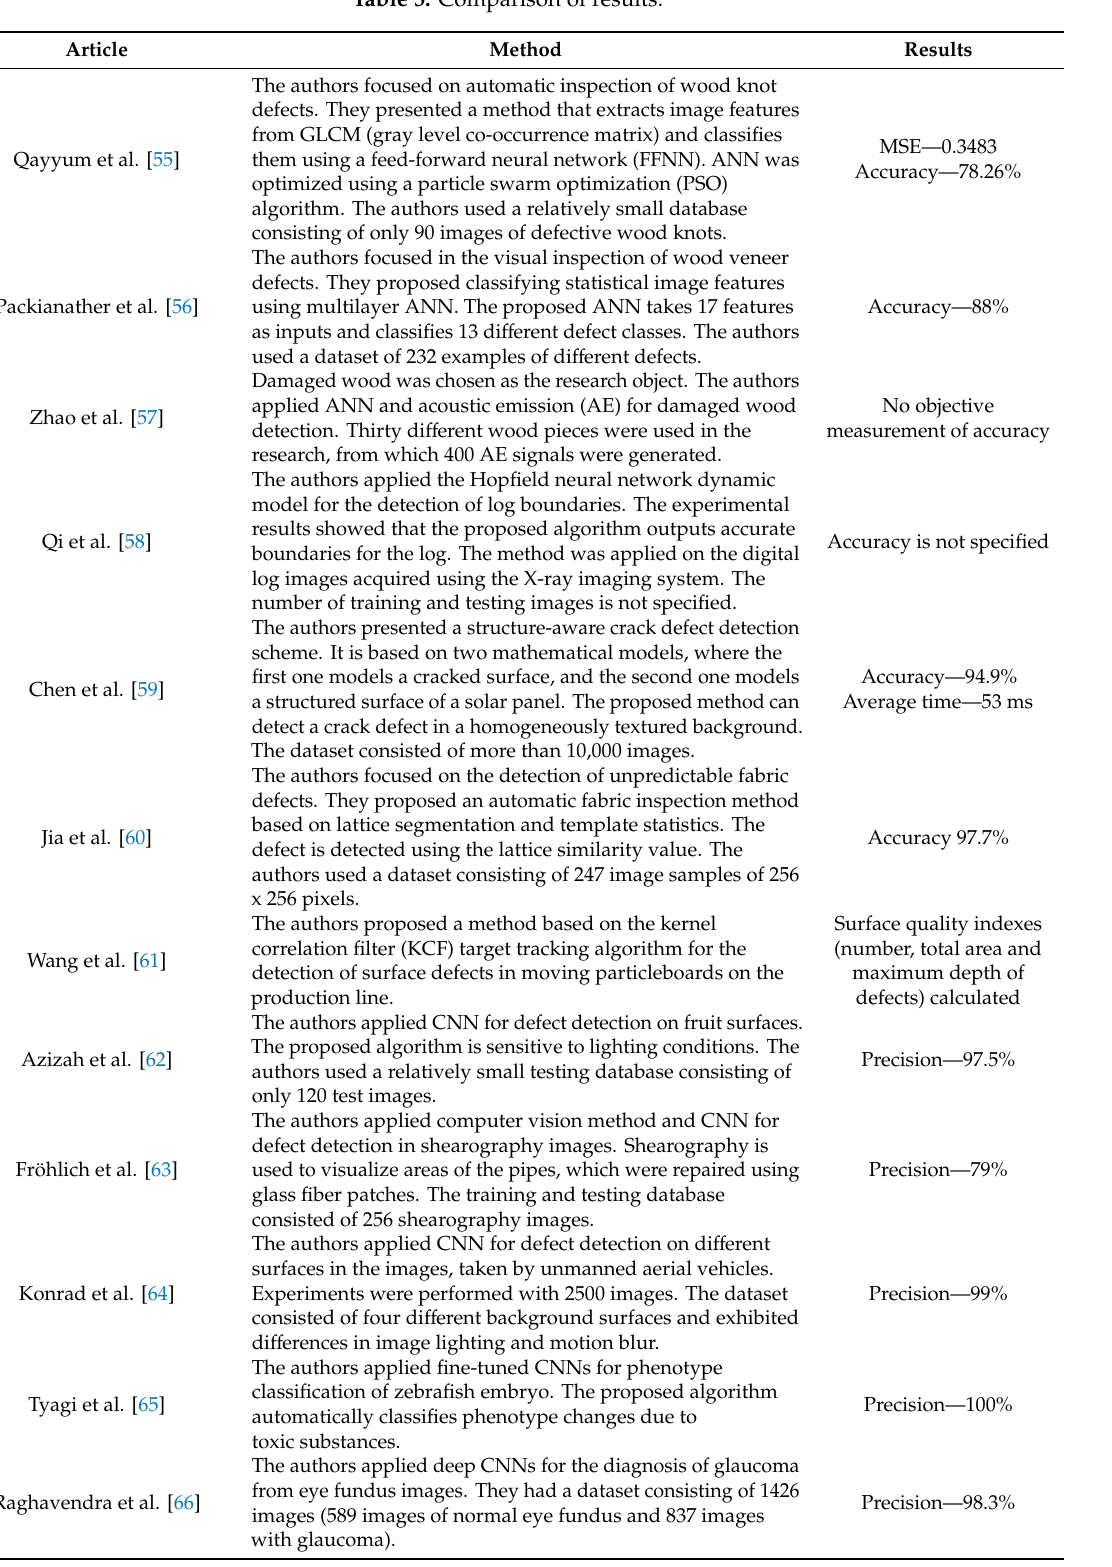
Table 5. Comparison of